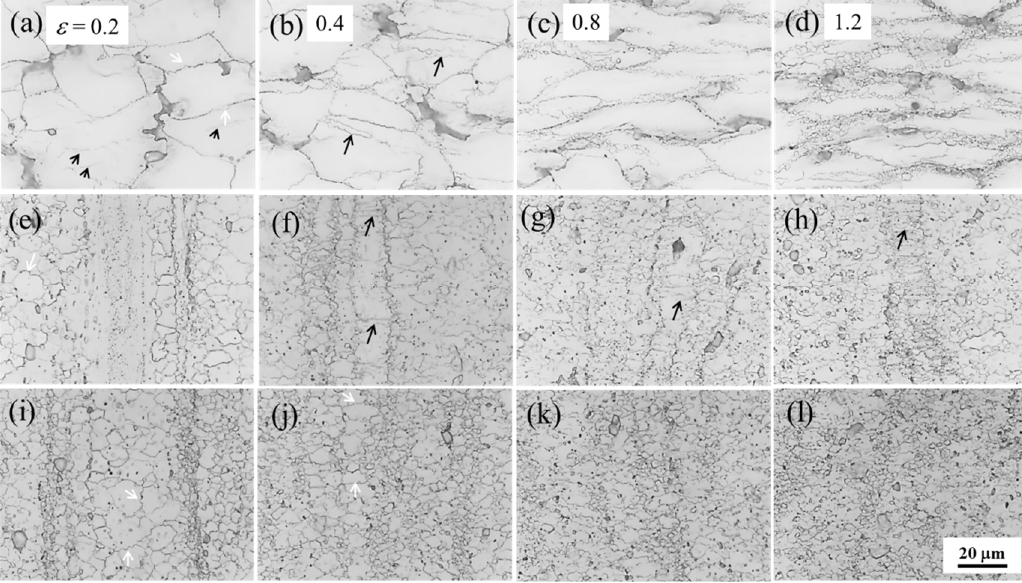
Figure 9. Typical microstructures after being compressed at a strain rate of 0.05 s − 1 with various true strains of 0.2, 0.4, 0.8, and 1.2 for ( a – d ) AC, ( e – h ) Ex-l, and ( i – l ) Ex-2 WE43 alloy, respectively.